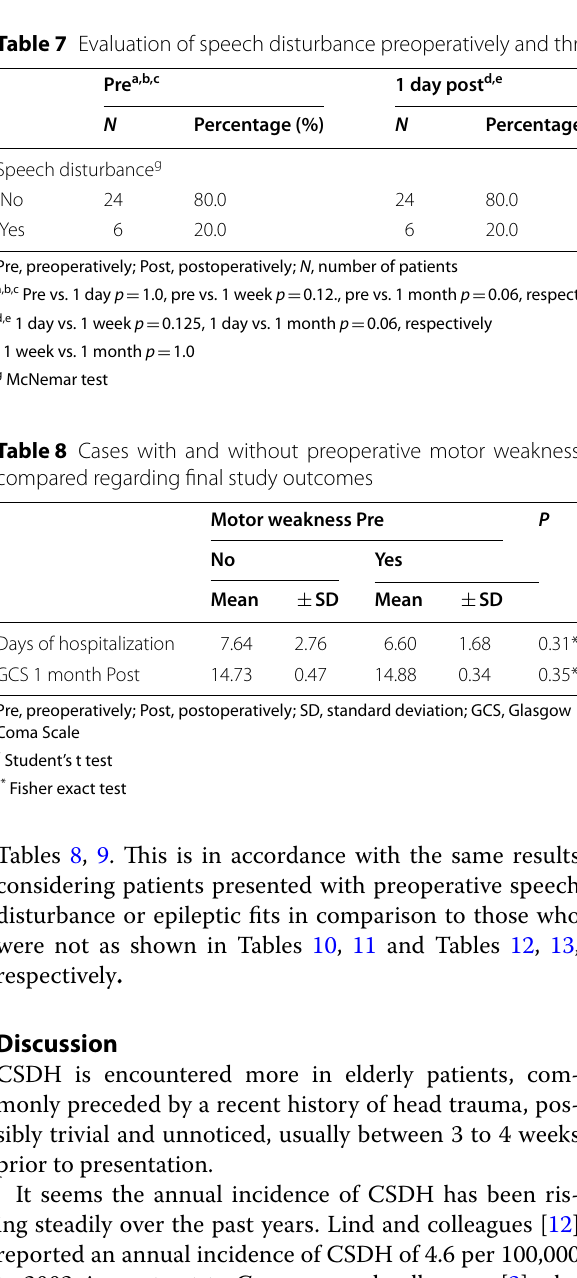
Table 7 Evaluation of speech disturbance preoperatively and throughout the postoperative follow-up period